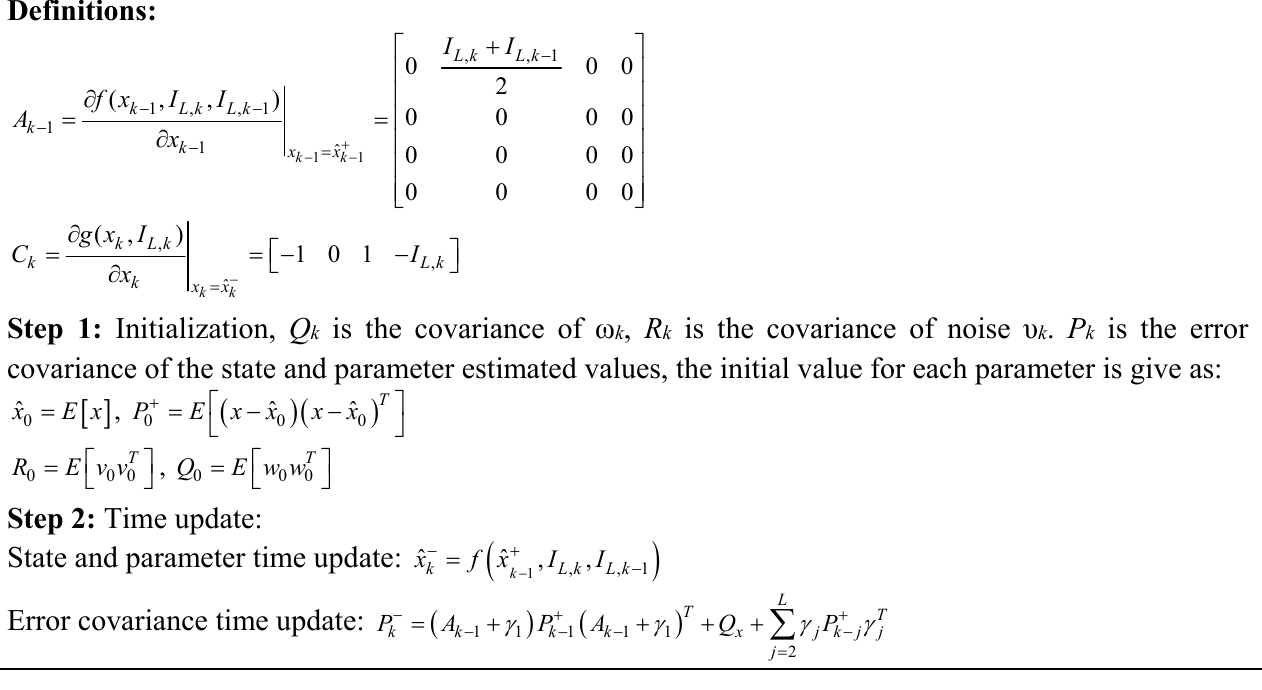
Algorithm 1 Model parameter identification based on